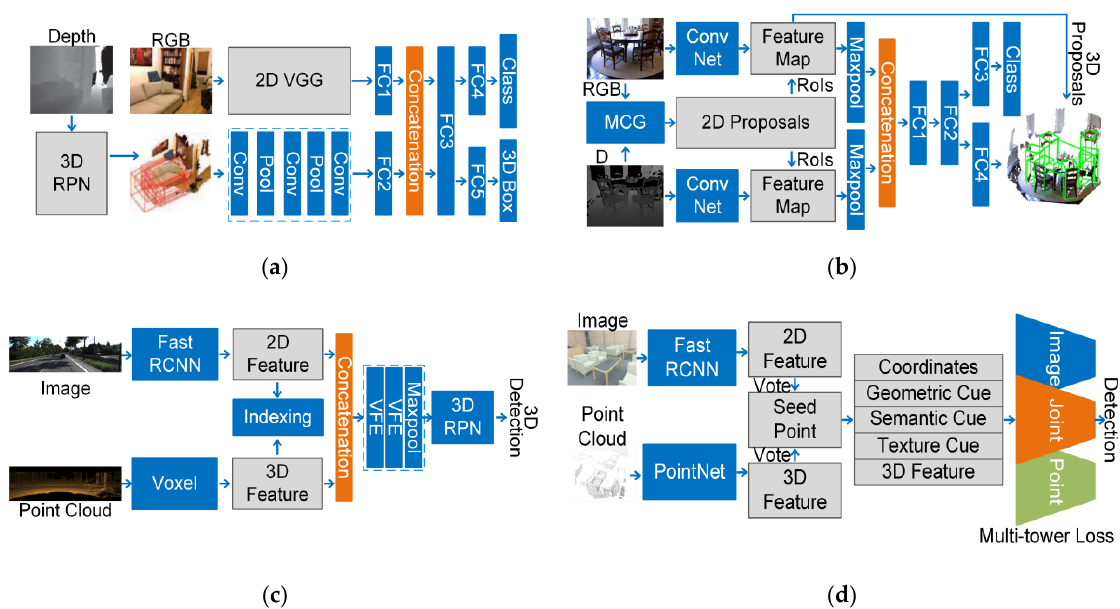
Figure 7. The representative detection methods using one-stage feature-based fusion strategy. ( a ) The joint object recognition network; ( b ) The structure of the method; ( c ) MVX-Net; ( d ) ImVoteNet. (2). Point Cloud Registered with Images